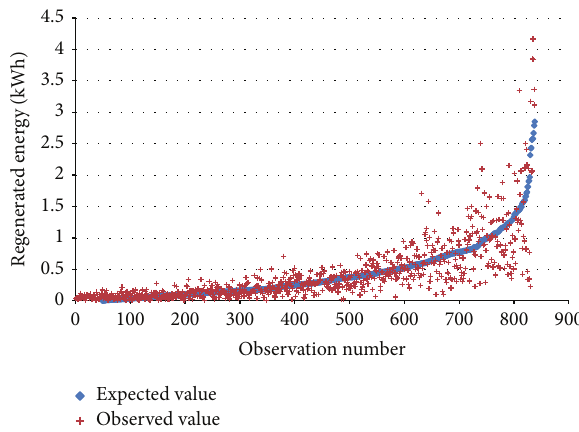
Figure 4: Observed and expected regenerated energy of electric vehicle trips. Source: own